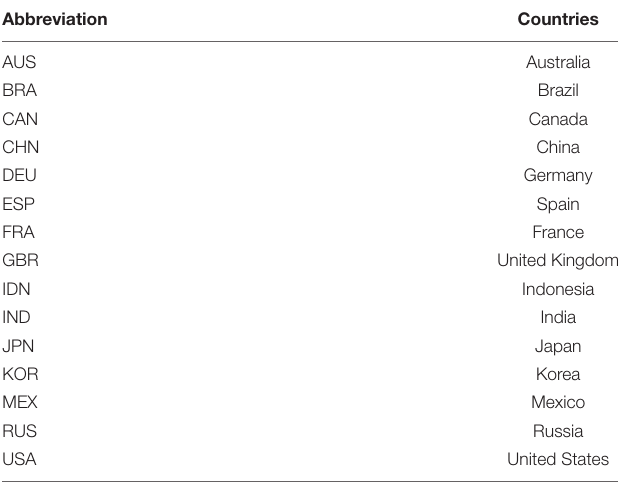
TABLE 1 | Major countries and their abbreviations.